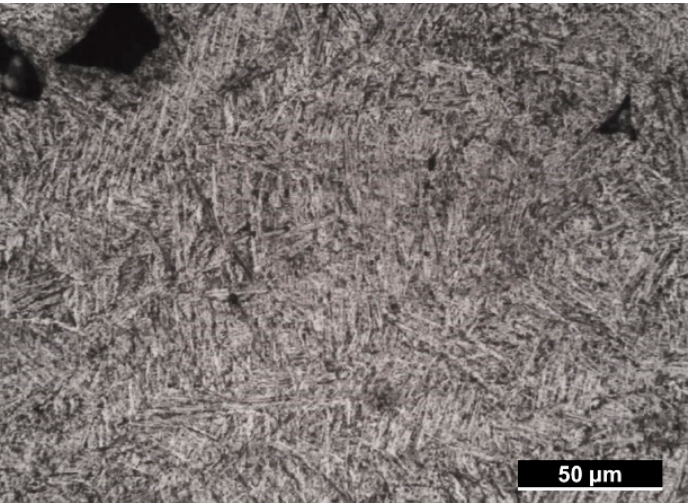
Figure 4. Representative microstructure after stress relief heat treatment. Basket weave microstructure is apparent.